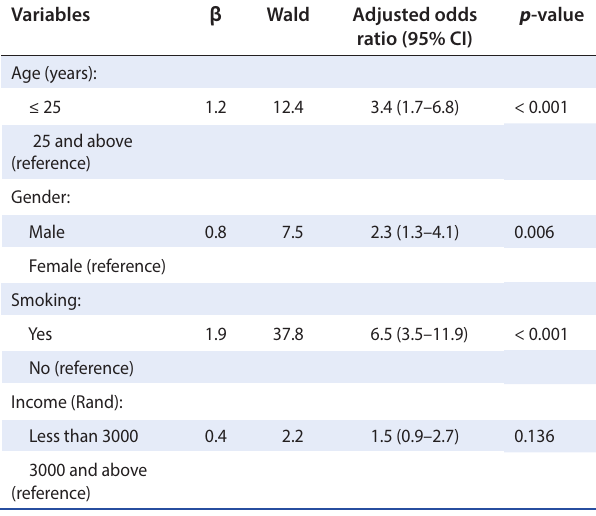
Table 3: Multivariate logistic regression showing predictors of binge